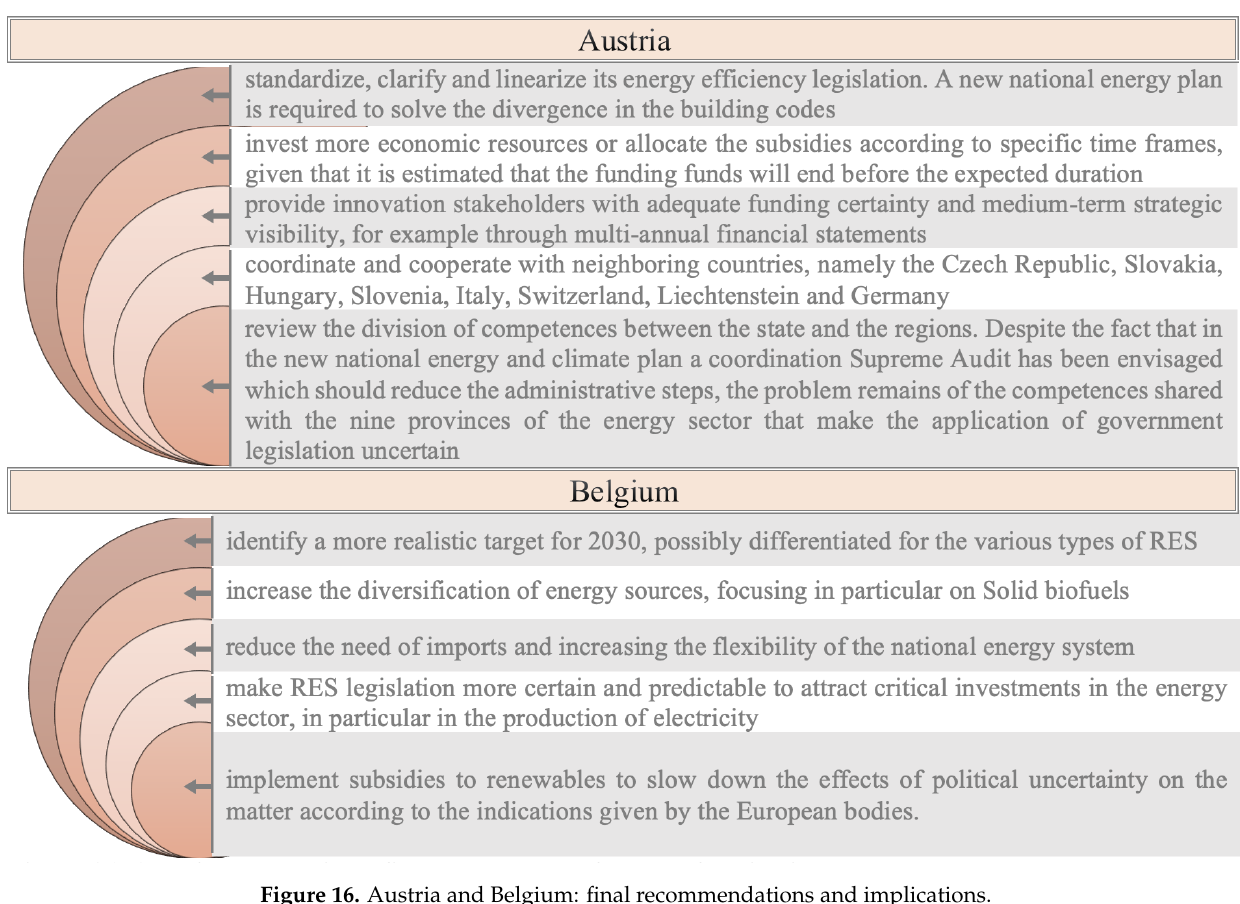
Figure 16. Austria and Belgium: final recommendations and implications.